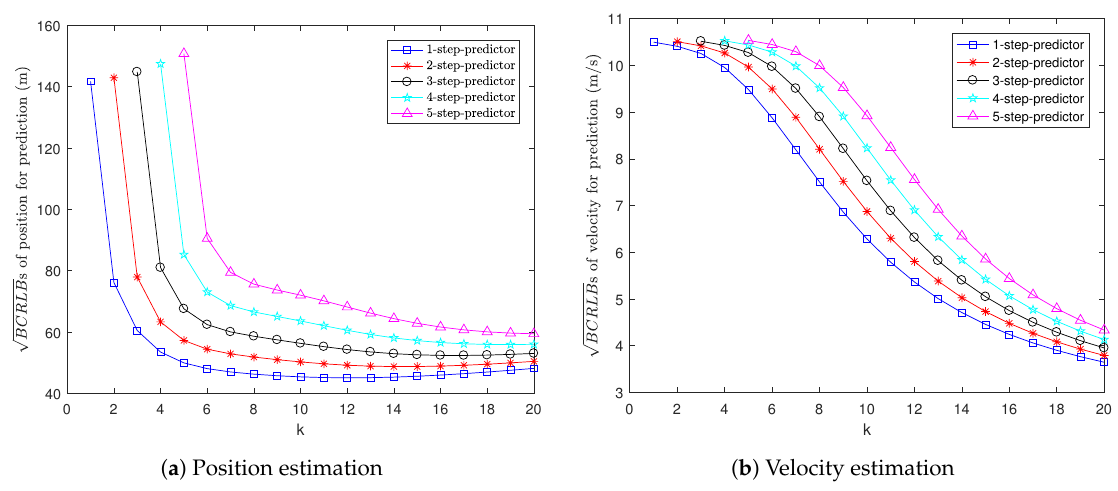
Figure 1. RMSE versus